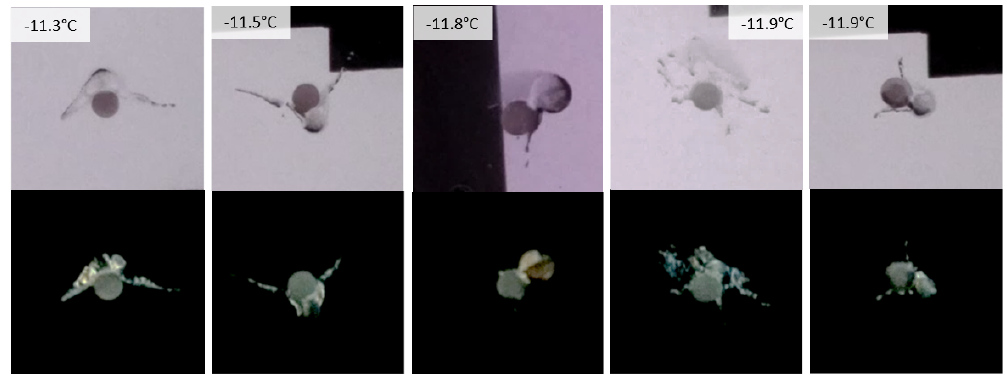
Figure 7. Frames from the RPicam configuration approximately 10s after a supercooled water drop impact for experiments at T > − 11 ◦ C. The top panel shows frames from the RPicam with no polarising filter, and the bottom panel shows frames from the RPicam with a polarising